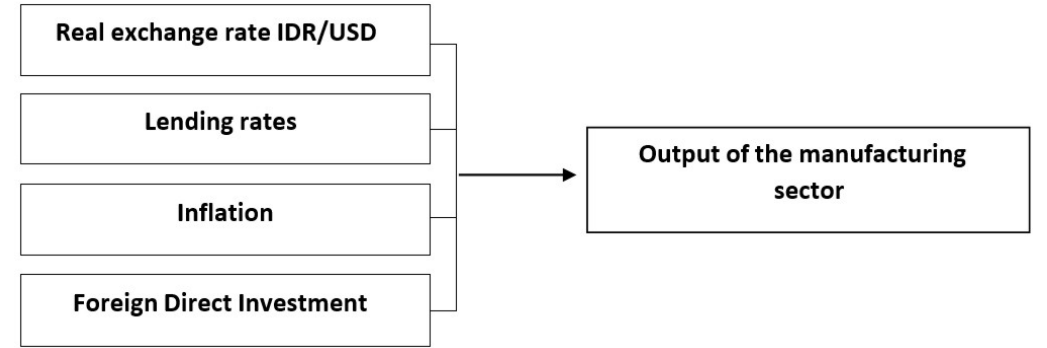
Figure 4: Thinking Output Template Manufacturing